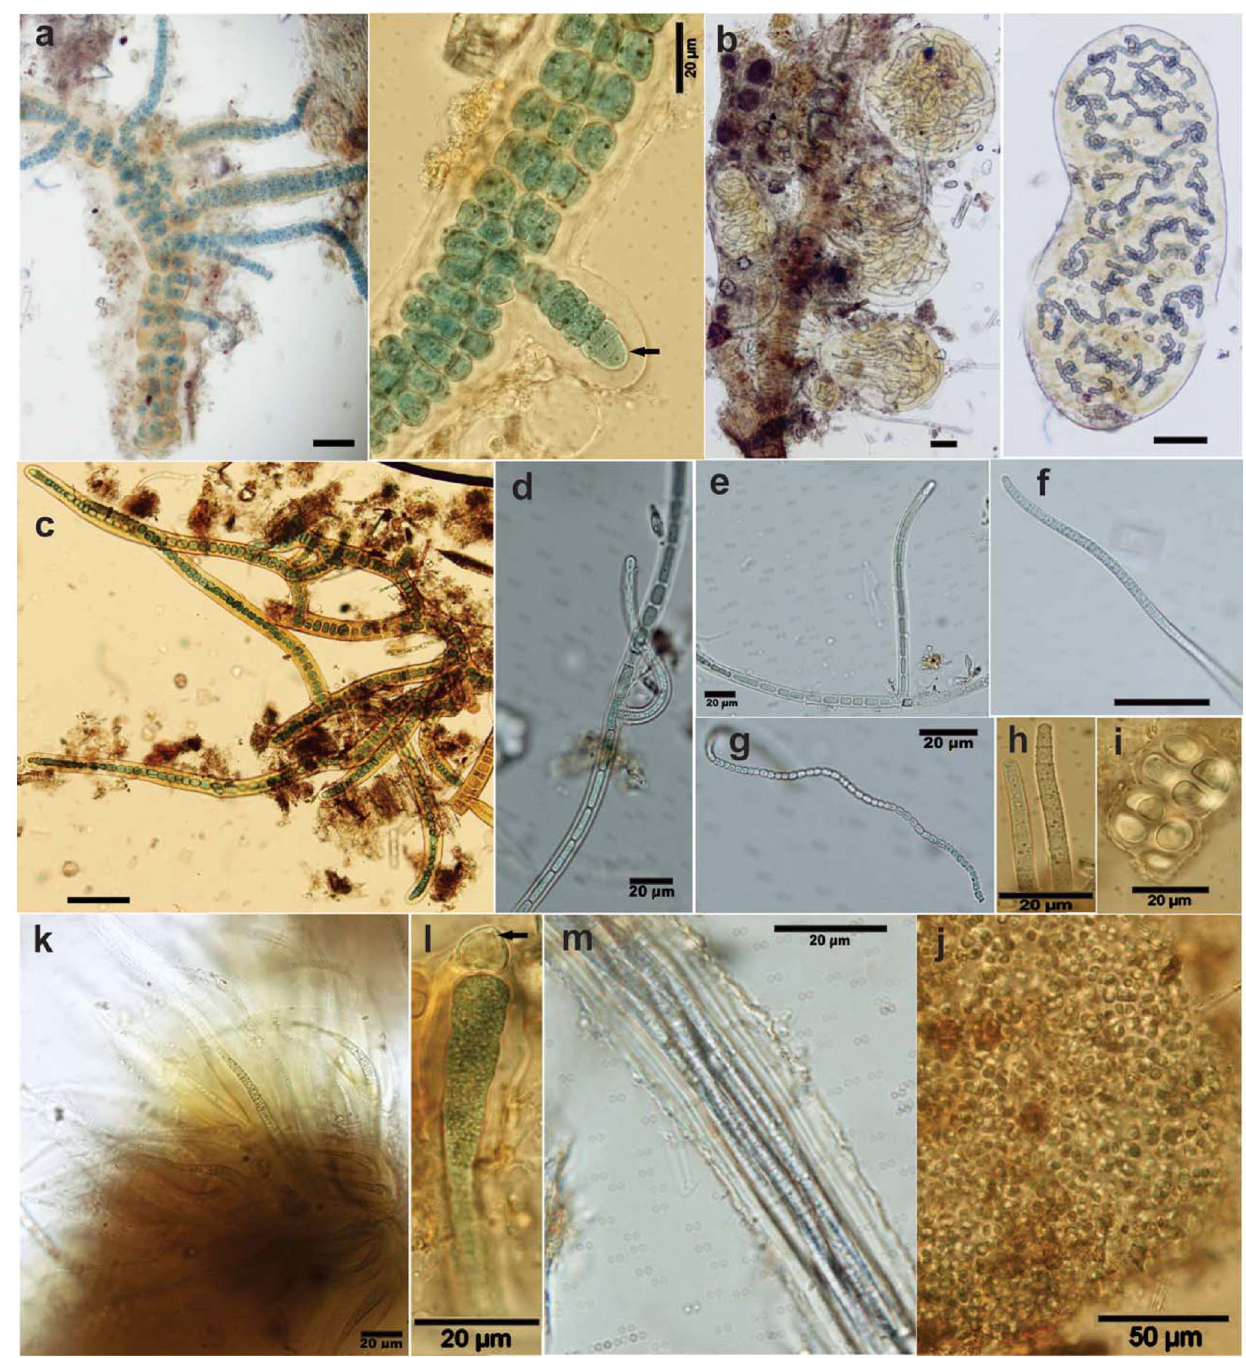
Figure 3. Representative cyanobacterial morphotypes identified in wetland meadows along the Lais, Vindel and Pite Rivers in northern Sweden. a) A filamentous, multiseriate cyanobacterium of the Stigonema type with multiple, true T-branches within a sheath (Vindel River). The right-hand micrograph shows a detail of a branching filament, with granulated vegetative cells, and a nitrogen-fixing heterocyst at the end of one branch (arrow). b) Rounded Nostoc -like colonies associated with vegetation debris. The right-hand part shows the winding heterocystous filaments embedded within a gelatinous matrix/sheath (Vindel River). c)–e) False branching uniseriate filamentous cyanobacteria of the Scytonema - type; c) within a distinct yellow-brown sheath (Lais and Vindel Rivers). f)–h) Filamentous non-heterocystous cyanobacteria of the Oscillatoria -type (Vindel and Pite Rivers) and in g) thin filaments of the Leptolyngbya -type. i)–j) Unicellular cyanobacterial colonies (Vindel and Pite Rivers). k)–l) Heterocystous cyanobacteria of the Calothrix type with tapering filaments within yellow-brown sheaths; k) numerous clustered filaments, and l) part of a filament with a heterocyst at the widening basal part (arrow) (Vindel River). m) Densely packed filaments of the non-heterocystous Microcoleus - type organized within a common sheath (Vindel River). Scale bar represents 50 m m, if not otherwise given.